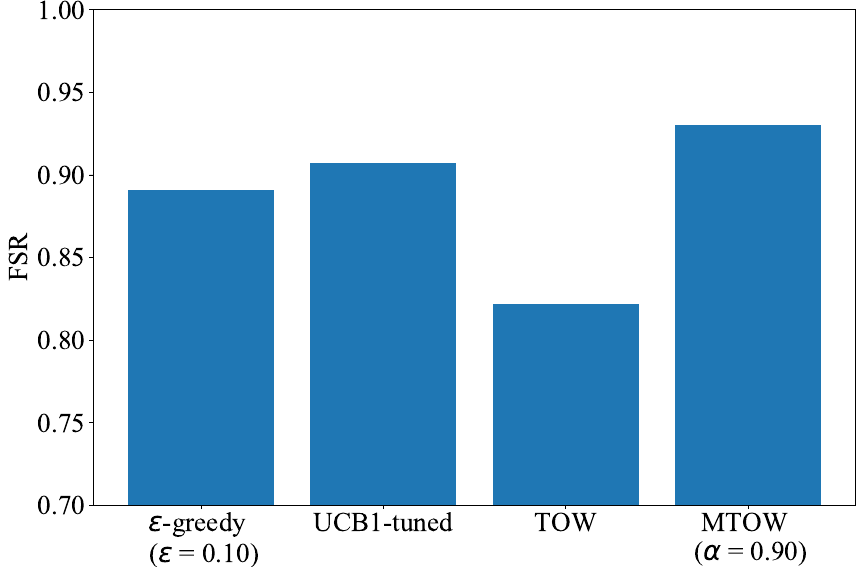
Figure 12. Implementation results in terms of FSR for the MAB-based channel selection